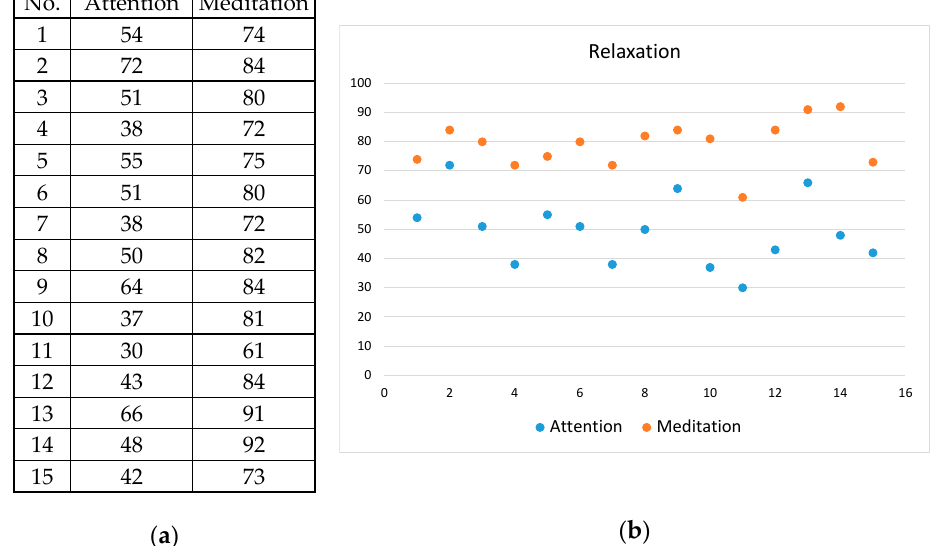
Figure A1. The data and the distribution graph of the average values of the 15 measured two-feature sample sequences of the emotion type of focusing, from which the corresponding decision rule a ≥ 70 and a ≥ m for emotion classification was inferred, where m and a represent the meditation and attention signals, respectively. ( a ) The average data. ( b ) The distribution graph.